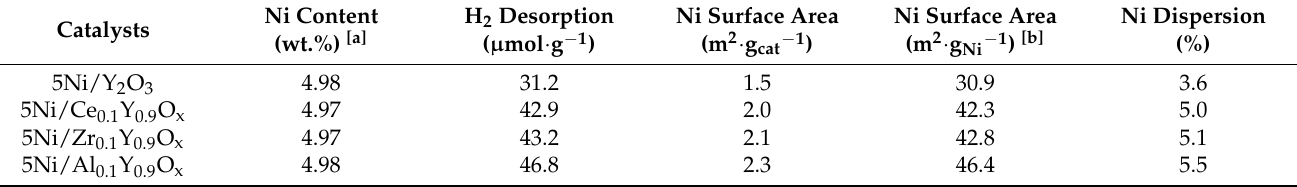
Table 5. Ni dispersion and metallic Ni surface areas of the reduced